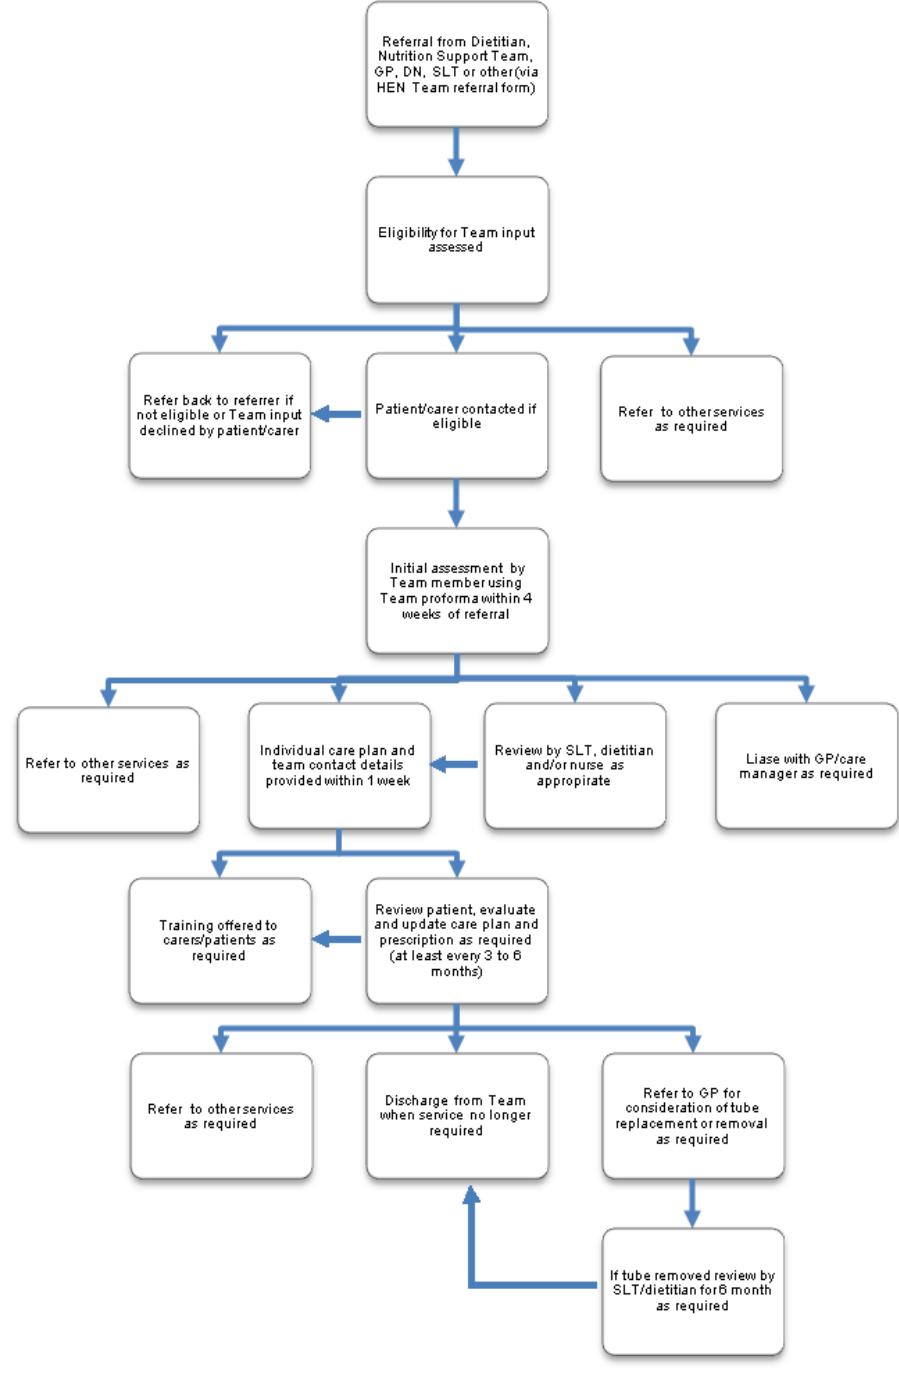
Figure 1. Care pathway for management of patients with enteral tubes by Home Enteral Nutrition (HEN) Team, Key: GP: General practitioner, DN: district nurse, SLT: Speech and language